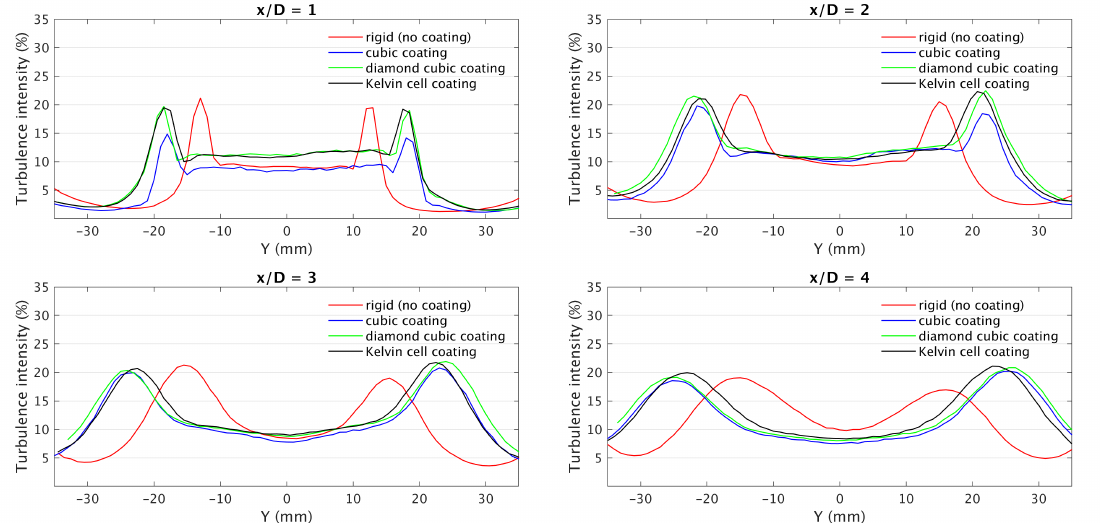
Figure 10. Turbulence intensity graph for cylinders